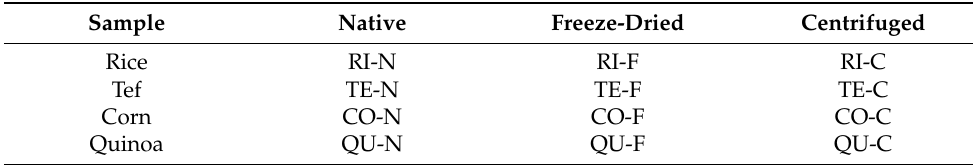
Table 1. Sample identification for the studied